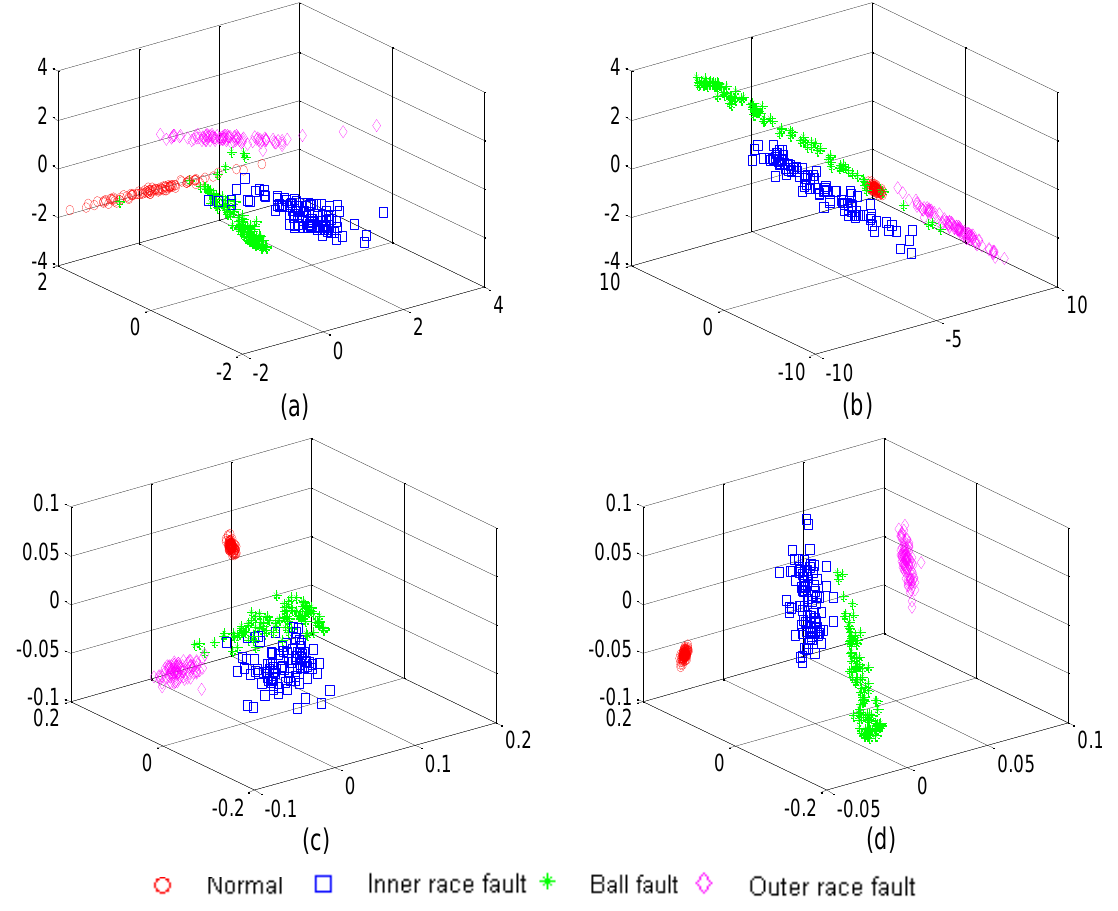
Figure 10. Feature dimension reduction to rolling bearing multi-domain feature in the dataset: ( a ) Mapping with PCA; ( b ) Mapping with LDA; ( c ) Mapping with LLE; ( d ) Mapping with